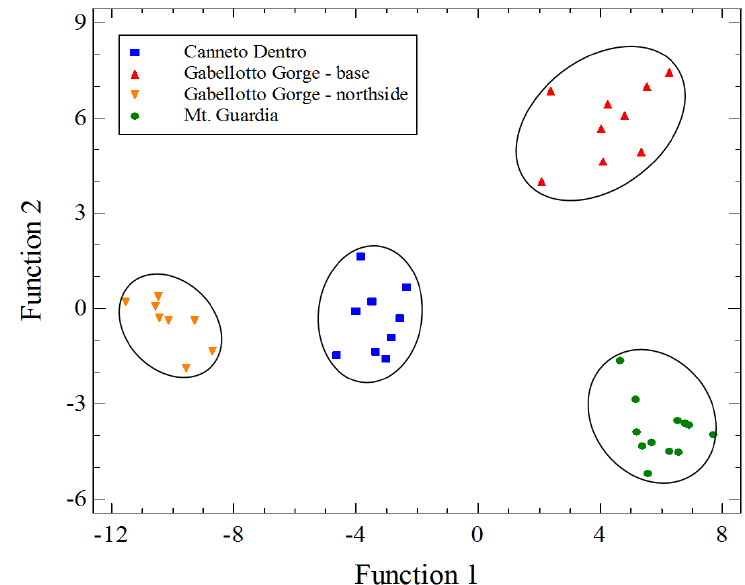
Figure 13. Discriminant function graph of prehistoric Lipari subsources by LA-ICP-MS. Over the past ten years, the pXRF analyses were conducted using different models of the Bruker Tracer, including the III-V+, III-SD, and V i . The settings have remained fairly similar, using a Cu-Ti-Al filter to reduce the background and increase the precision of the K-alpha peaks for Fe through Rb, while running at 40–50 kV and 10–35 μ A for 180 to 30 seconds. In each case, the results are calibrated using a large number of obsidian standards provided by MURR (Missouri University Research Reactor) and run directly on each instrument (Tykot, 2017b). When using the pXRF, which produces quantitative data on fewer trace elements than the other methods, assignment of an artifact to a specific Lipari subsource is dependent mainly on the concentration of strontium, with the base of Gabellotto ~20 ppm, the northern area of Gabelloto ~30–35 ppm, and at Canneto Dentro ~40–70 ppm. More than 60 prehistoric geological subsource samples have been tested by pXRF (Figure 14).